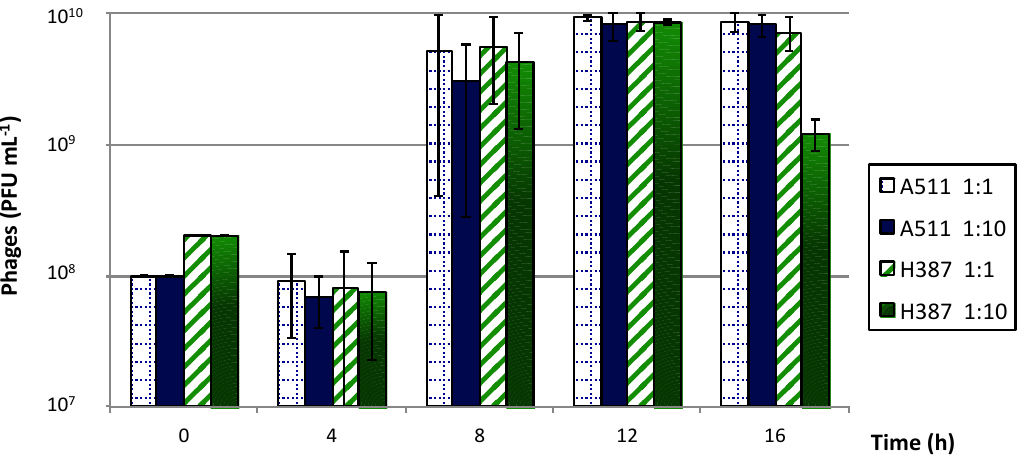
Figure 3. Production of phages A511 and H387 on Listeria ivanovii WSLC 3009 in liquid medium, using multiplicities of infection (MOIs) of 1 and 0.1. Phage counts were measured every 4 h. Mean values were calculated from two independent experiments, and error bars correspond to standard deviations.